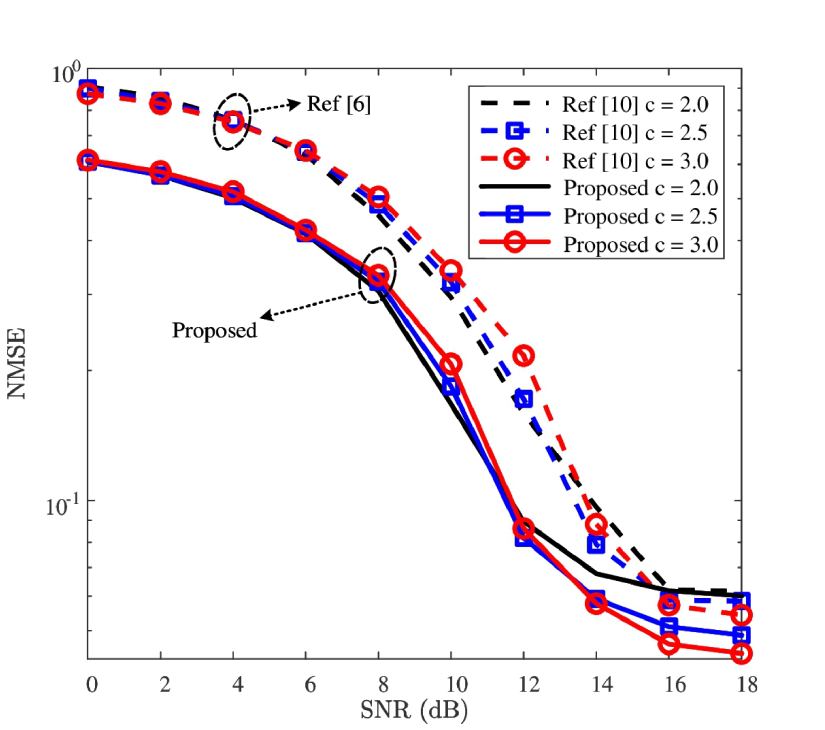
Fig 10. NMSE versus SNR, where P = 512 and ρ = 0.10 are considered, and the β of Ref [10] is 10.